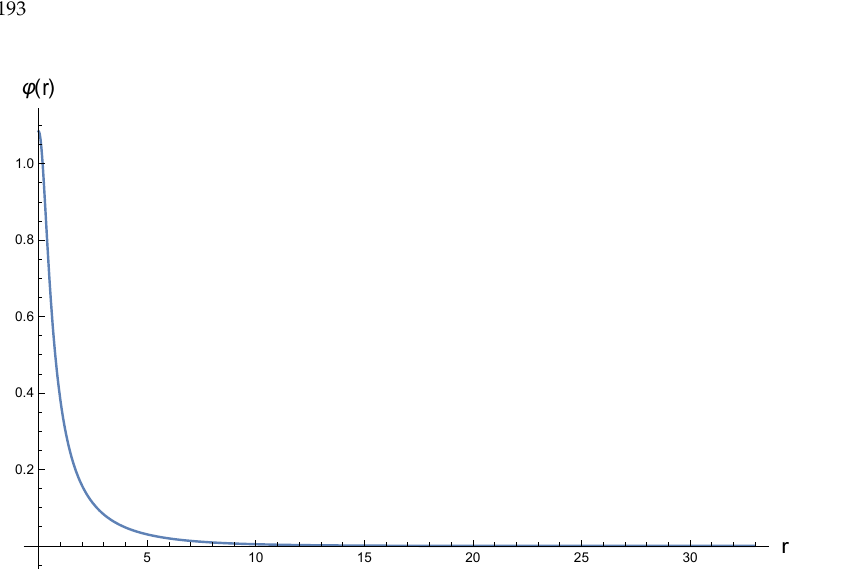
Figure 1. Typical form of the ϕ ( r ) distribution exponentially decreasing at large r .